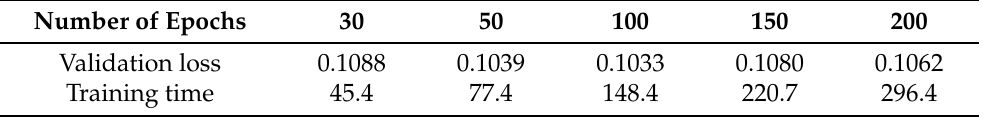
Table 6. Validation losses and training time (s) of the p2p module under different epochs while the number of hidden layers is two and number of nodes of each hidden layer is 15.